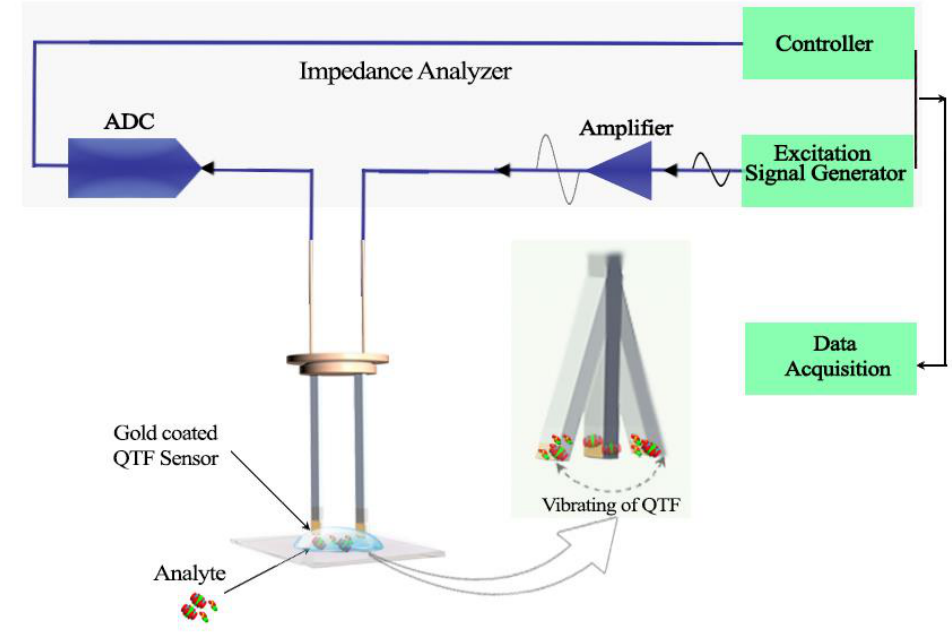
Figure 1. Schematical illustration of the QTF measurement system used.